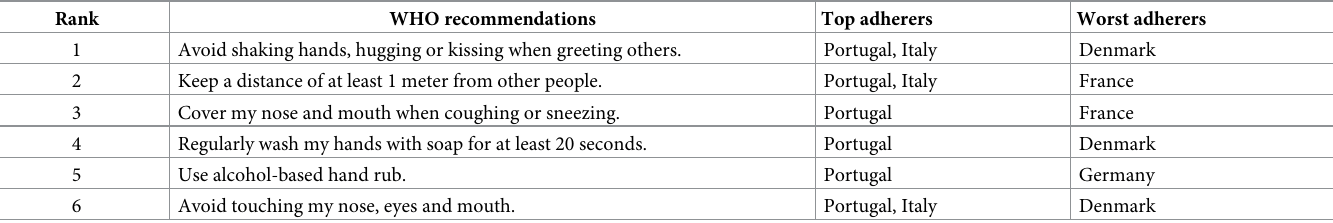
Table 2. Rank of WHO recommendations in the order of their relative adherence. Rank WHO recommendations Top